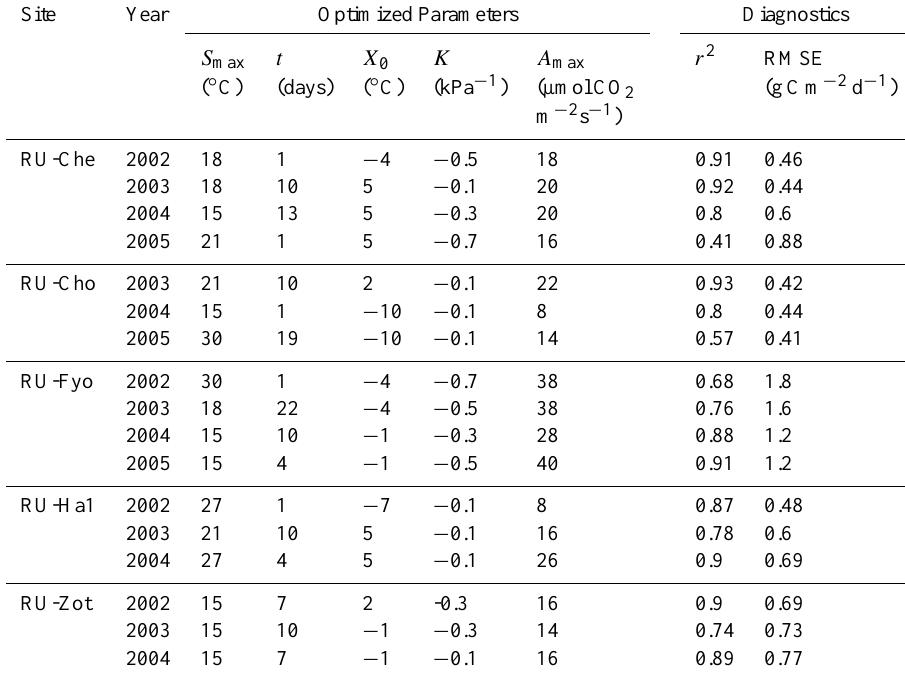
Table 6. Resulting optimized model parameters and regression diagnostics for the BL model by site and year. Site